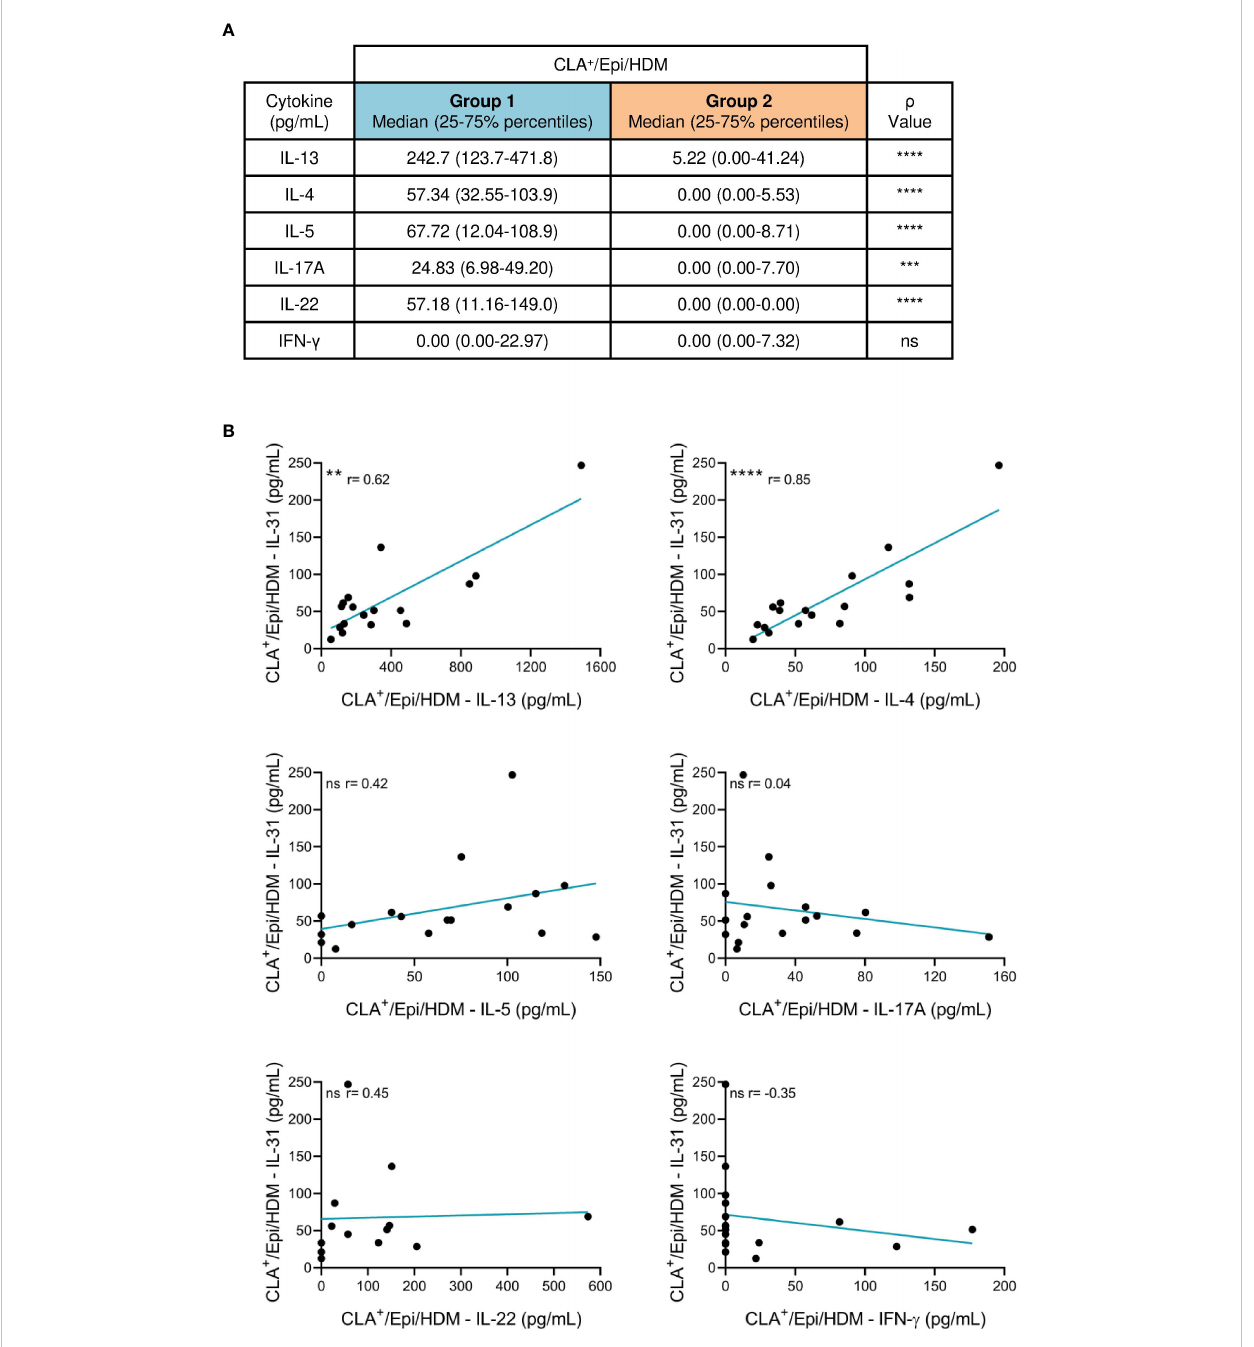
FIGURE 2 Patients producing IL-31 (group 1) by HDM-stimulated CLA + T cells have a more in fl ammatory phenotype than patients with undetectable IL-31 (group 2). (A) IL-13, IL-4, IL-5, IL-17A, IL-22 and IFN- g (pg/mL) produced by HDM-induced CLA + T-cell cocultures was compared between groups 1 (n=13-17) and 2 (n=35-41) of patients. (B) In group 1, HDM-stimulated CLA + T-cell-dependent IL-31 production was correlated with IL-13 (n=17), IL- 4 (n=17), IL-5 (n=17), IL-17A (n=17), IL-22 (n=13) and IFN- g (n=17). CLA, cutaneous lymphocyte-associated antigen T cells; Epi, epidermal cells suspension; HDM, house dust mite. ns: p >.05; **p <.01; ***p <.001; ****p